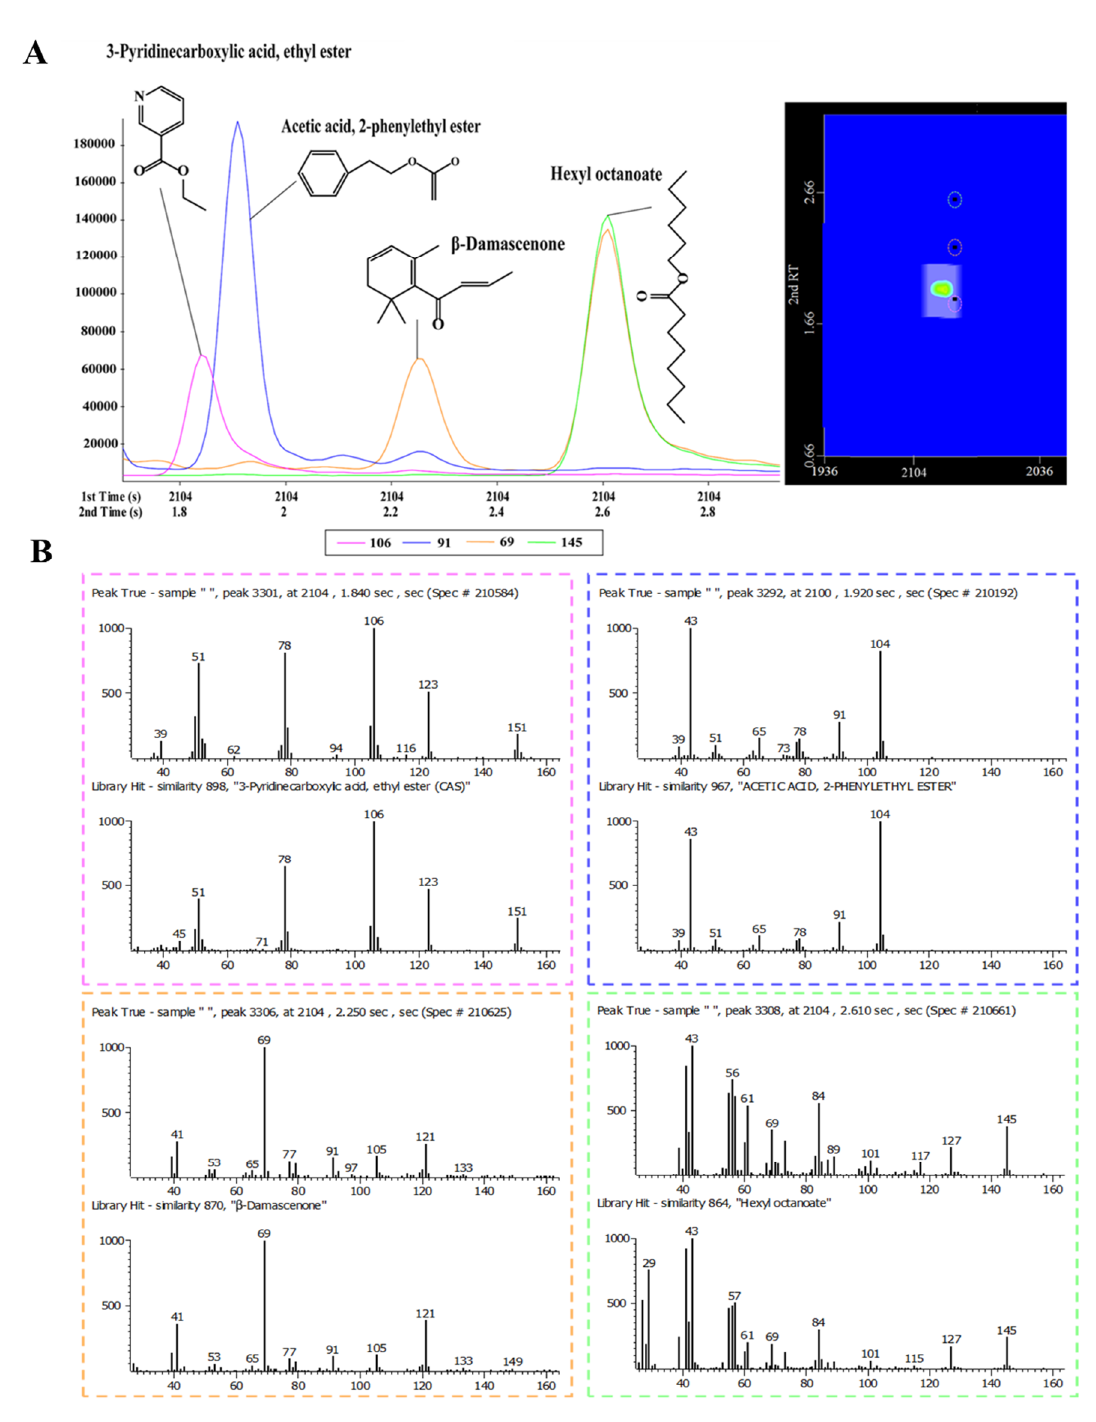
Figure 2. ( A ) Four peaks shown in the two-dimensional chromatogram and modulated peaks of four compounds found in Chinese herbaceous aroma-type Baijiu. ( B ) Deconvoluted mass spectra of compounds.